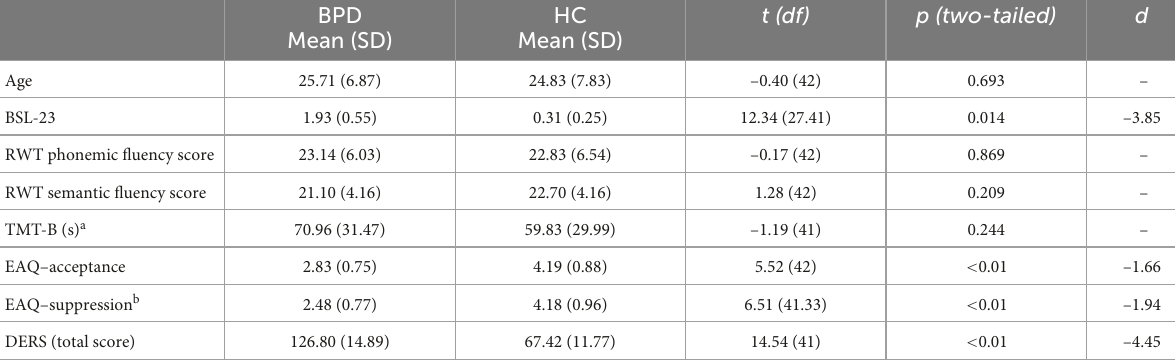
TABLE 1 Demographic, neurocognitive, and psychometric data of individuals with borderline personality disorder (BPD) and healthy control